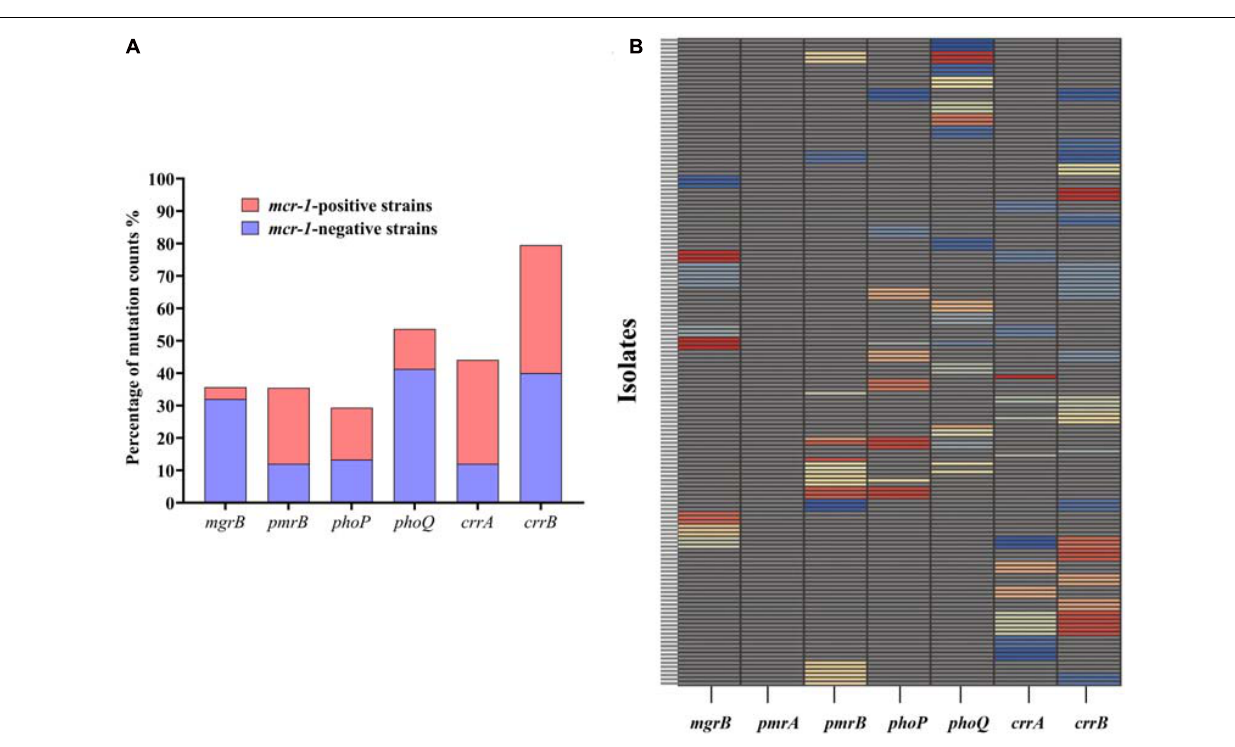
FIGURE 3 | Occurrence of genetic alterations in mgrB , pmrAB , phoPQ , and crrAB in K. pneumoniae . (A) Distribution of mutations in different genes in 81 mcr-1 -positive and 75 mcr-1 -negative K. pneumoniae derivatives. (B) Profiles of genetic alterations in key genes related to colistin resistance, with 53 unique combinations in the 156 colistin-resistant K. pneumoniae derivatives. Each unique mutation in each colistin resistance gene is represented by a different color. Specific information on the mutations can be found in Supplementary Table 4